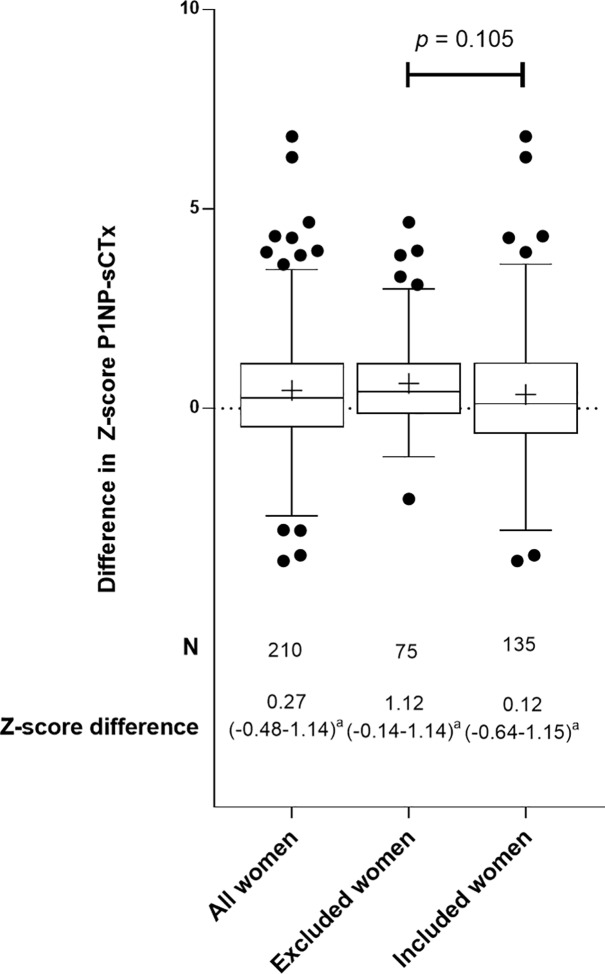
Difference in Z-scores for PINP and sCTx after RRSO in all women (N = 210), excluded women with recent fractures or currently using HRT or AI or ever using AOD (N = 75) and women included for regression analyses (N = 135).Box-and whisker plots (Tukey): boxes indicate medians with interquartile ranges; + indicate means; whiskers indicate 1.5 times the interquartile distances; ∙ indicate outliers. a. p < 0.05; difference in Z-scores are compared to a median difference of 0.